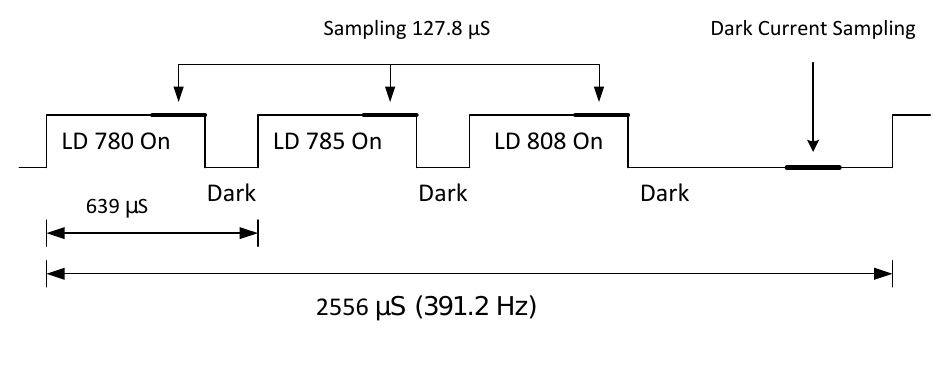
Figure 6. Schematic presentation of the time division of the laser diode activation between the three